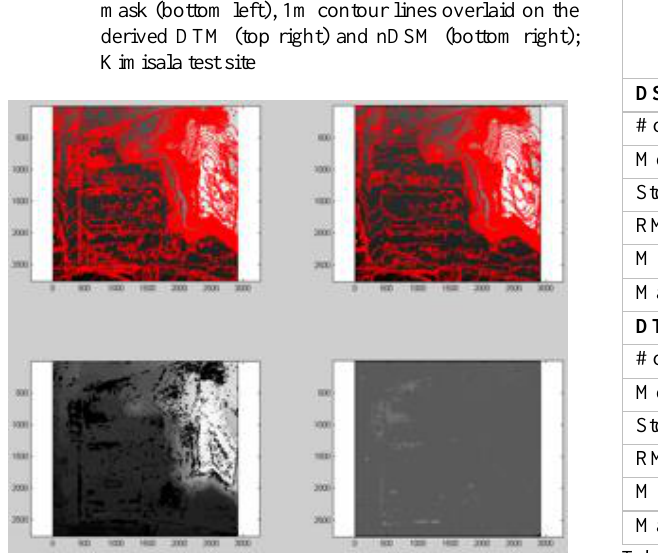
Figure 13: Overlaid Contour lines on the initial DSM (top left), mask (bottom left), 1m contour lines overlaid on the derived DTM (top right) and nDSM (bottom right);